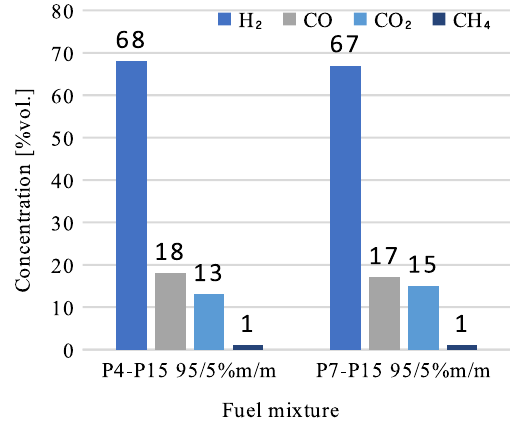
Fig. 5 Gas concentrations in the co-gasification